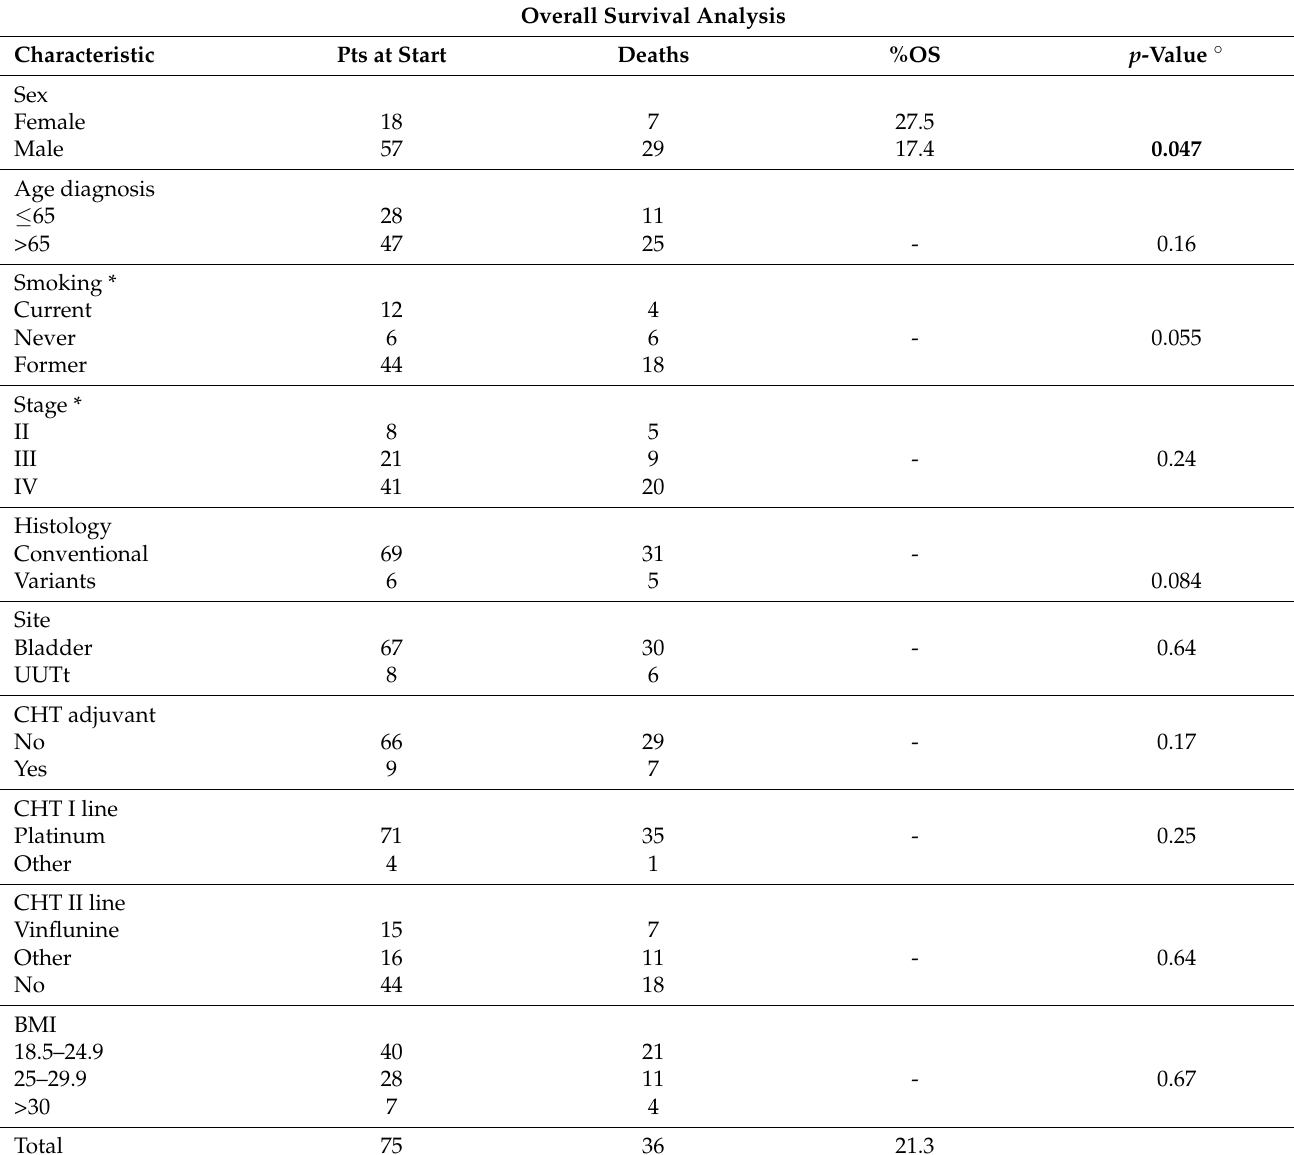
Table 2. Kaplan–Meier OS analysis at the end of follow-up (at 120 months). Overall Survival